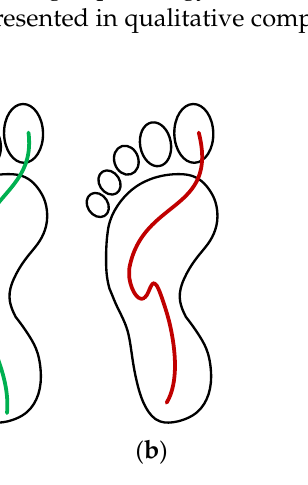
Figure 4. Center of pressure progression line for ( a ) physiological gait, ( b ) abnormal gait.